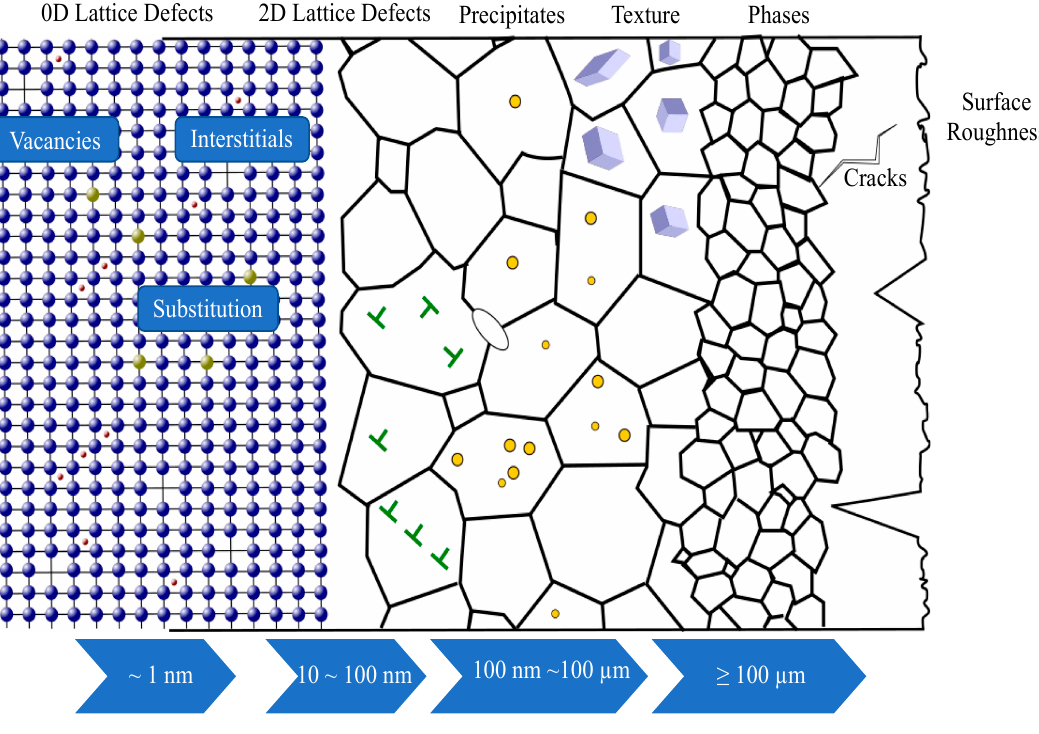
Figure 16. Schematic representation of different types of microstructural defects.